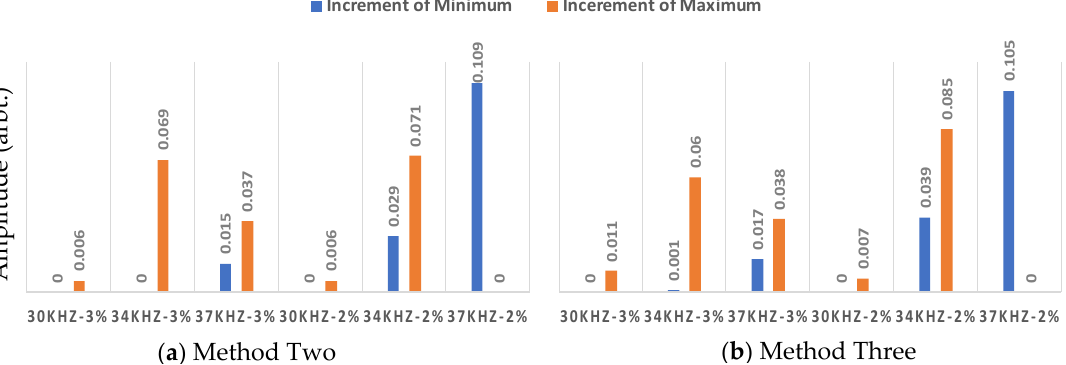
Figure 14. The increments achieved using the second version of thresholding in the first set of tests.